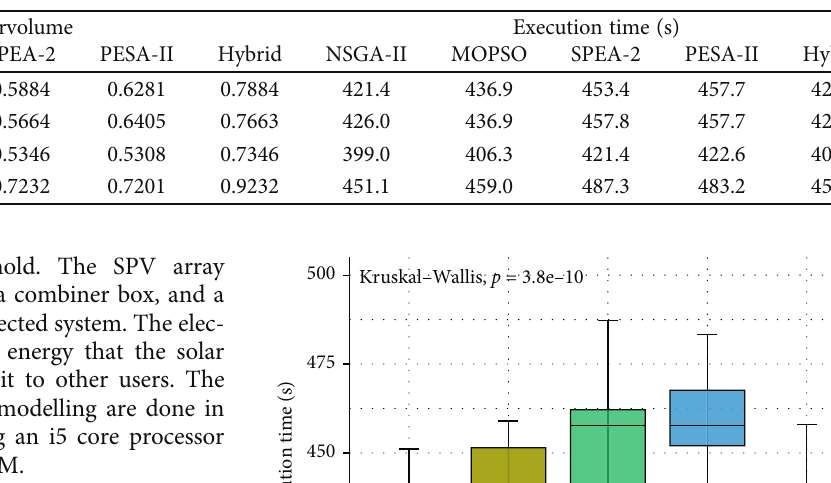
Table 5: Comparison of the hybrid algorithm with four other standard MOEAs based on hypervolume (convergence, diversity) and execution